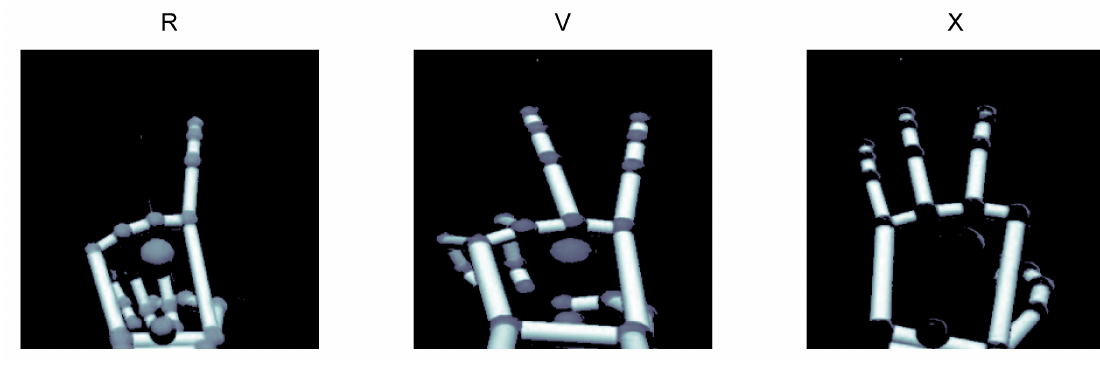
Figure 6. Example of signs recognized.